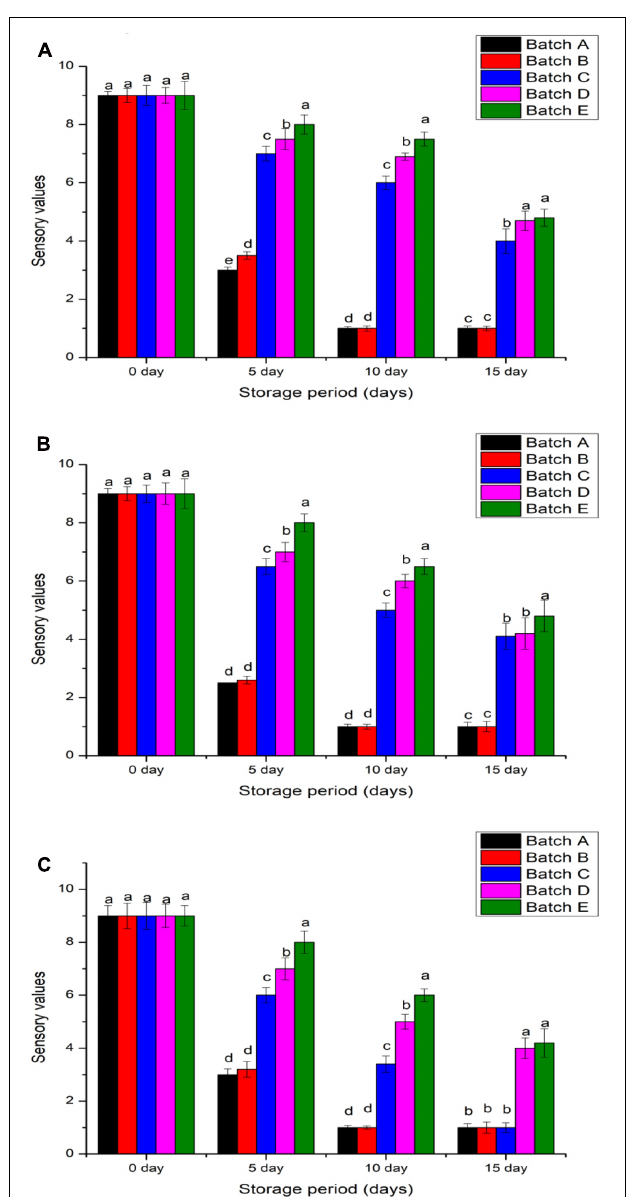
FIGURE 7 | Total viable counts of samples (A) Penaeus merguiensis , (B) Pampus argenteus , and (C) Tenualosa ilisha. Batch A: normal untreated, Batch B: treated with 2% glacial acetic acid, Batches C, D, and E were treated with different types of 2% chitosan solutions (0, 10, and 20 kGy). Value is provided as mean ± SE ( n = 3). The same letters (a–e) over the bar plot stands for insignificant difference ( p > 0.05).